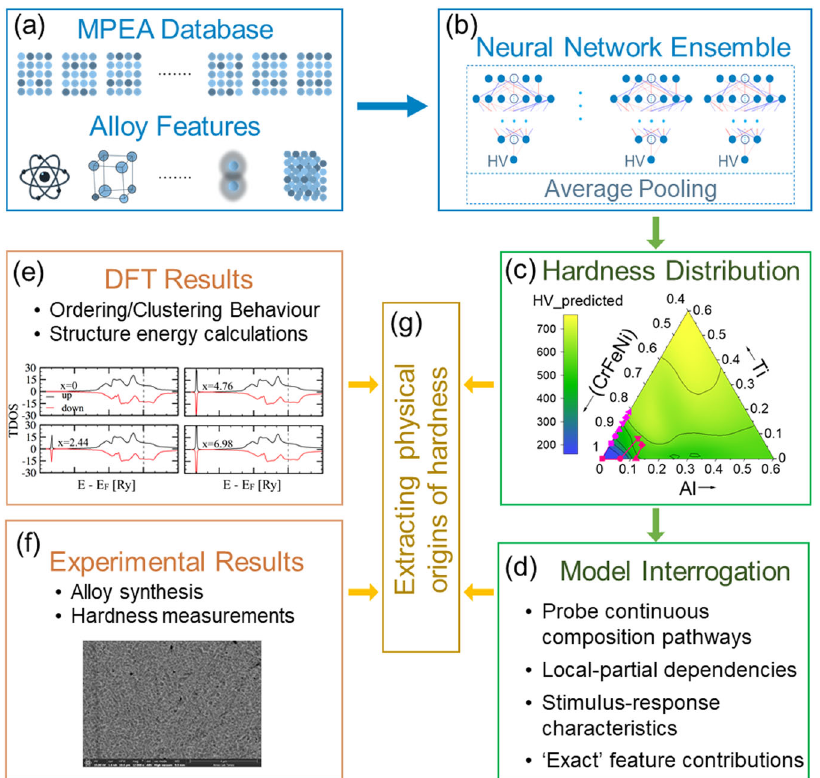
Fig. 1 Overview of the methodology used for extracting origins of hardness. a MPEAs hardness database development and calculation of alloy features, b training of neural network ensemble, c exploration of hardness over wide compositional spaces, d model interrogation to extract exact feature contributions along continuous composition pathways, ( e ) DFT results to probe ordering behaviour and structure stabilities, f experimental validation over complex alloy systems, and g analyzing the results to establish physical origins of